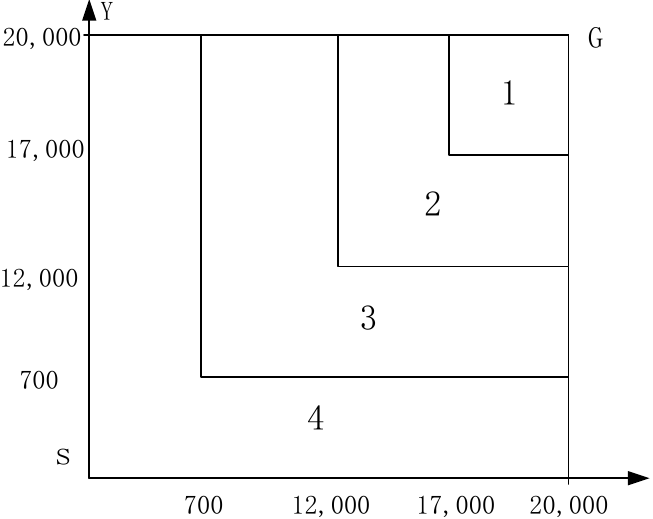
Figure 4. Distribution of the initial state setting in curriculum learning.